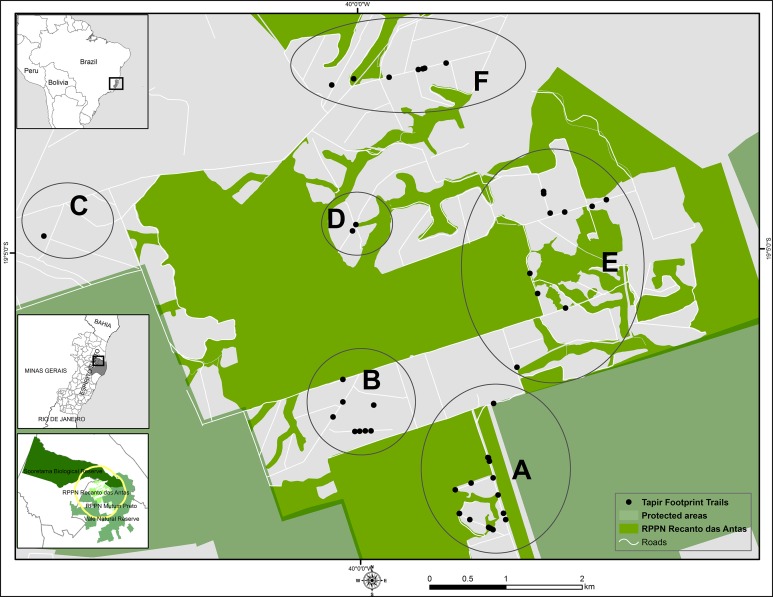
Survey sites for lowland tapir footprints.Location of the main survey sites (A–F) used for lowland tapir footprints survey in the Private Natural Heritage Reserve Recanto das Antas and surroundings, Espírito Santo, Brazil. Cartographic base source: protected areas—Cadastro Nacional de Unidades de Conservação (2015); political boundaries—Instituto Brasileiro de Geografia e Estatística (2001, 2005). Datum: World Geodetic System 1984 (WGS 1984). Coordinate system/projection: Universal Transverse Mercator (UTM) 24S.